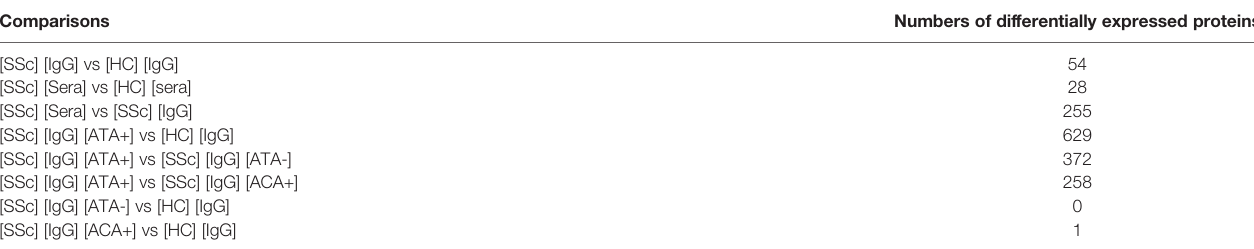
TABLE 1 | Comparisons considered for proteomic analysis and differentially expressed